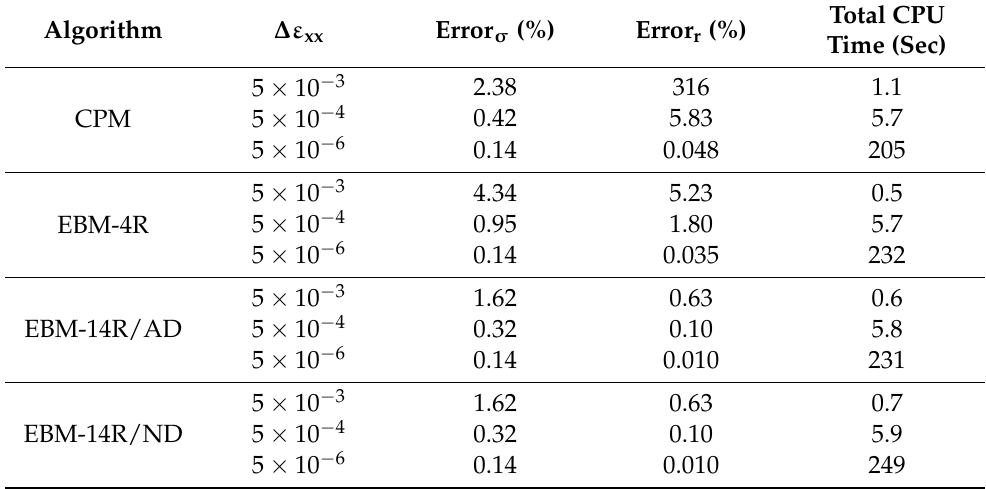
Table 3. Average relative errors in the flow curves and r-values of MAT 1 under C5T10R.